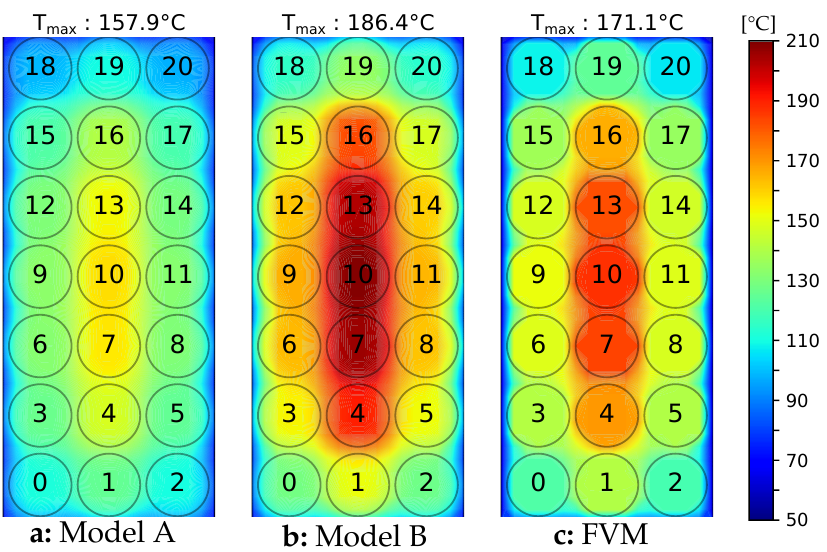
Figure A1. Comparison of thermal contours for rectangular shape with a square layout between method A ( a ), method B ( b ) and FVM ( c ). Results data from Table 1.